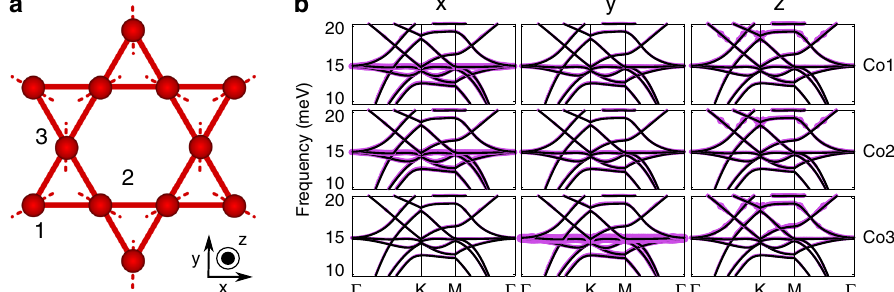
Fig. 5 Vibration nature of the phonon fl at band. a Kagome lattice with dotted lines denoting the directions in which the atomic movement is con fi ned. The inner atoms are displaced according to the elementary localized deformation that comprises the fl at band. b , Atom displacement resolved phonon band structure along x , y , and z -direction vibration for Co 1 , Co 2 , and Co 3 corresponding to a . The spectral weight is re fl ected by the line